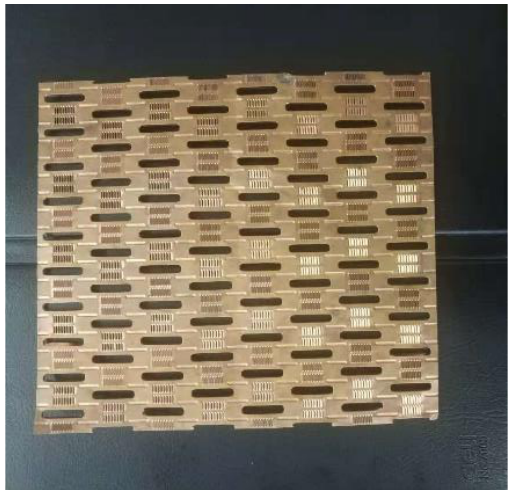
Figure 1. Diagram of the radiator